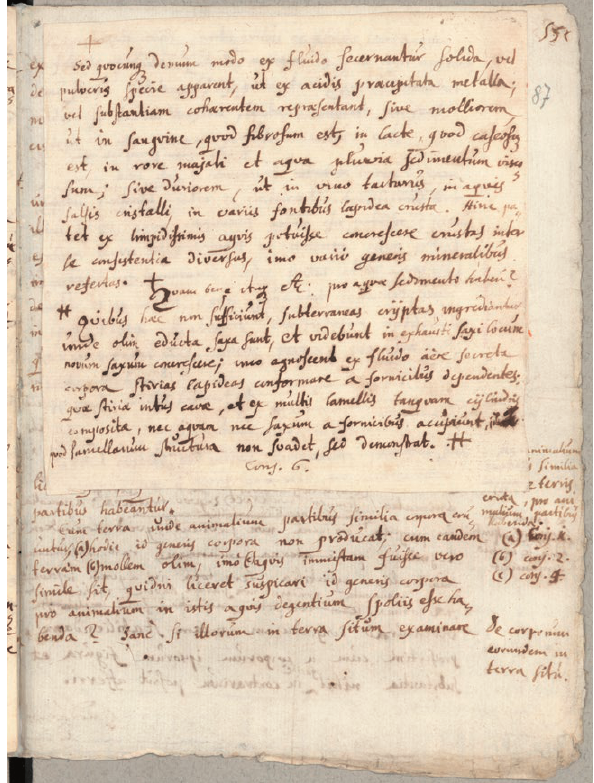
Figure 7. Steno’s model of Tuscany drawn by his disciple Holger Jacobæus (1650-1701), professor at the University of